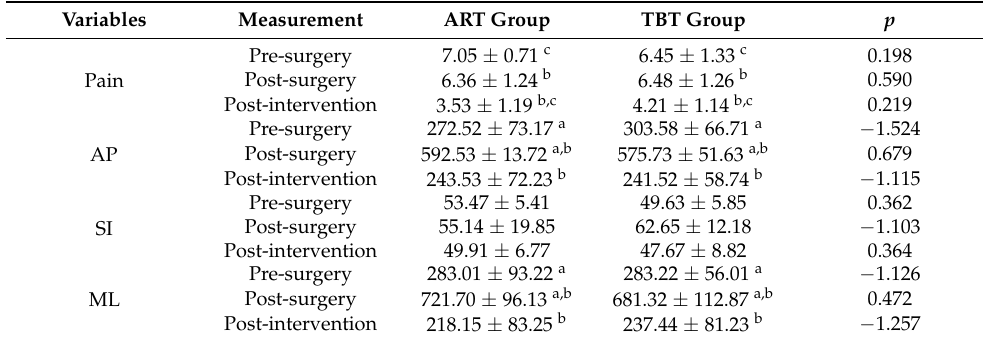
Table 4. Comparison of pain and balance within and between